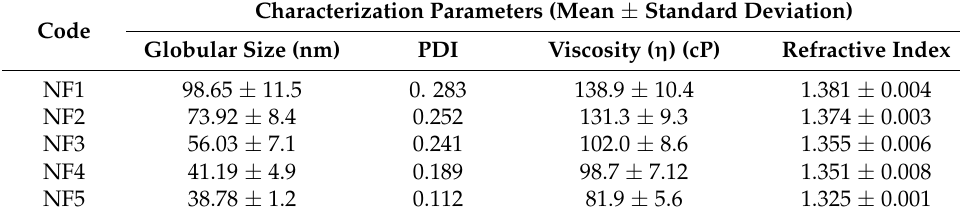
Table 3. Results of nanoemulsions (water/DMSOT/IPA/CMC8).